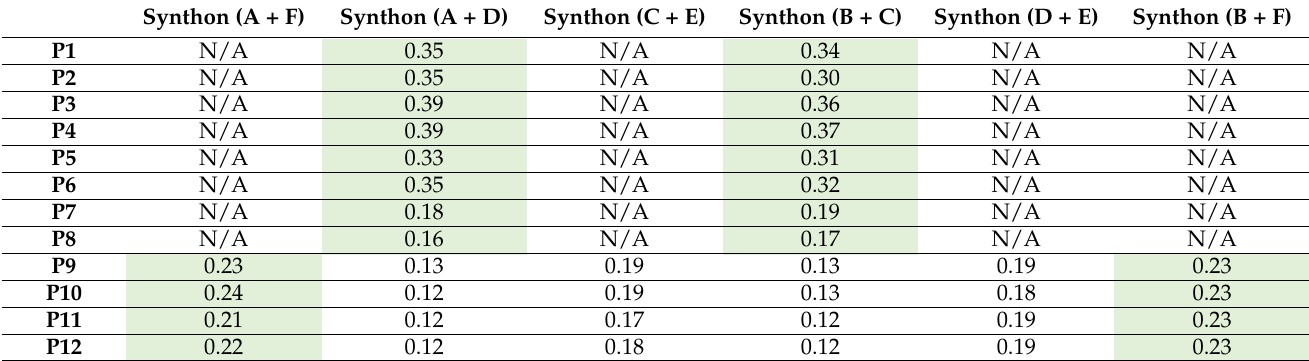
Table 2. Hydrogen-bond propensities (probability of interaction between a hydrogen-bond acceptor and donor) for combination synthons in molecules P1 – P12 . Combination synthon propensities are calculated by multiplying the individual synthon propensities. Green shade indicates the most likely predicted synthons by this method.